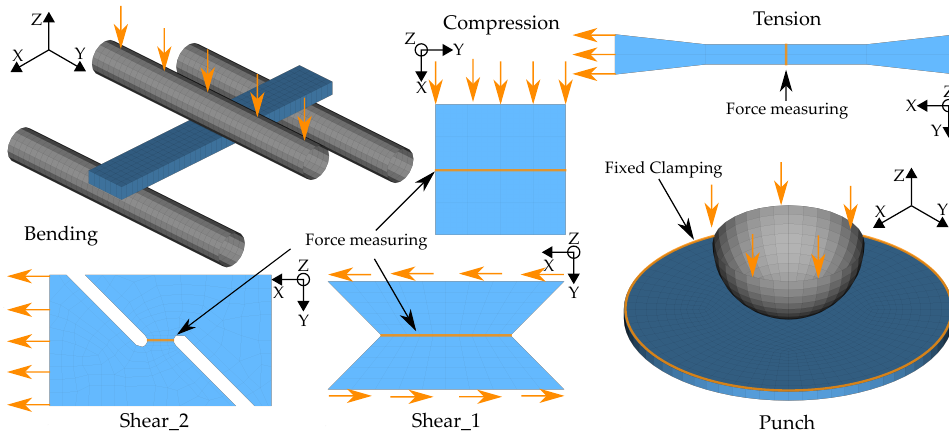
Figure 5. Created FE-models for the PI methods